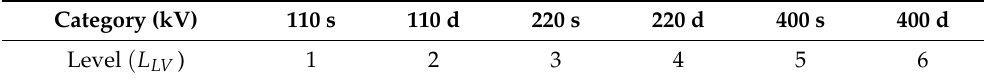
Table 7. Line voltage categories (s—single overhead line, d—double overhead